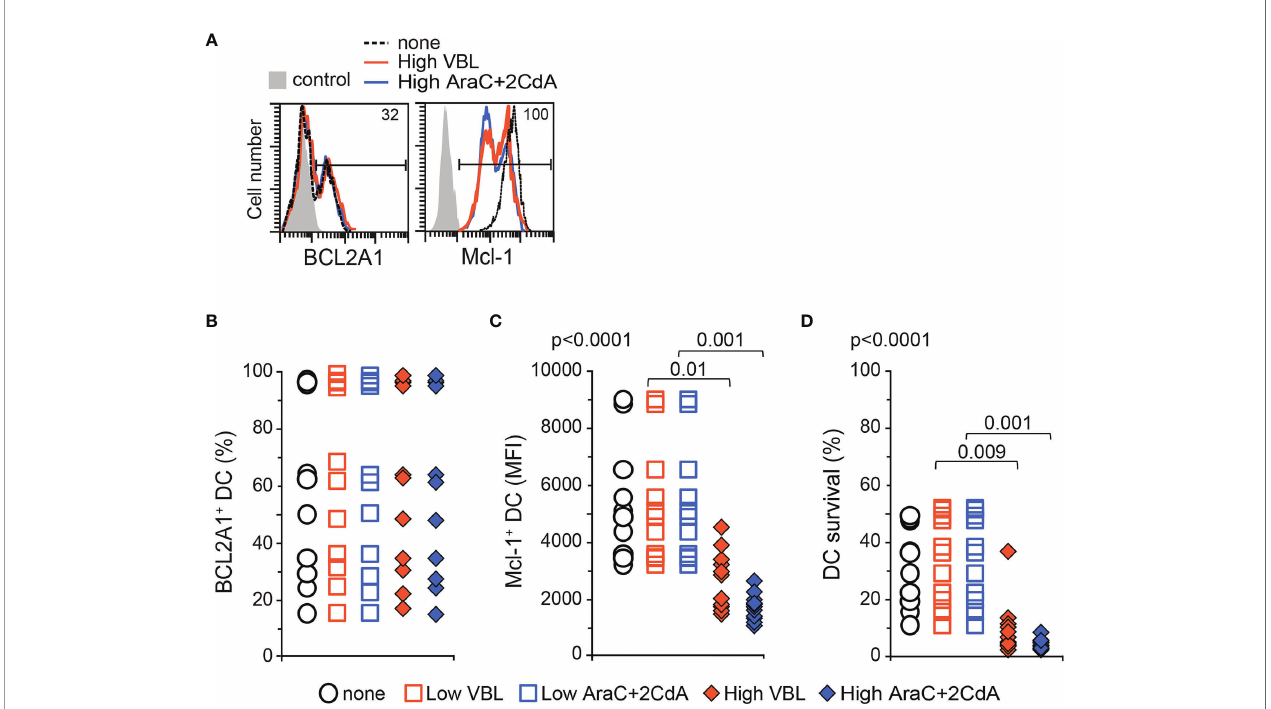
FIGURE 3 | BCL2A1 expression and survival in Mo-DCs from LCH patients after treatment with chemotoxic compounds. High doses of drugs correspond to 0.6, 40 and 3 m M for VBL, AraC and 2CdA, respectively. Low doses are 10 times lower. BCL2-member expression and survival were measured by fl ow cytometry in Mo- DCs with LCH. (A) Representative fl ow cytometry analyses of BCL2A1 and Mcl-1 intracellular staining after incubation with either medium alone (none, dotted black line) or high doses of VBL (full orange line) or AraC and 2CdA (full blue line). Percentage of positive Mo-DCs from LCH patient is indicated inside each histogram. Control (grey) corresponds to isotopic control at staining. Percentages of intracellular (B) BCL2A1 and (C) Mcl-1 expression in the Mo-DCs from LCH patients after culture with either medium alone (none) or with low or high doses of VBL (Orange) or AraC and 2CdA (Blue). For Mcl-1 quanti fi cation, the mean fl uorescence intensity (MFI) was more informative than the percentage because >95% of Mo-DCs expressed Mcl-1 in the absence of toxic compounds. (D) Percentage of DiOC + 6 PI – viable Mo-DCs from LCH patients treated or not with toxic drugs were quanti fi ed after 7 days of culture (initial density of one million Mo-DCs). (B – D) The mean of triplicate values was plotted for each patient. SD were below 2%. One symbol corresponds to one patient. Mo-DCs from 11 LCH patients (p1b, p2b, p7c, p6b, p9, p12, p13, p14, p16, p19, p20) were analysed. Statistical analyses: the Kruskal-Wallis test with Steel-Dwass-Critchlow-Fligner post-test were used to compare the groups and calculate the p